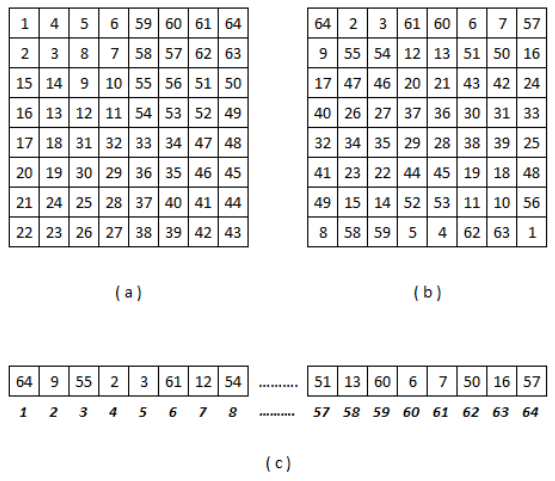
MCU i ( t ) inside i = 1